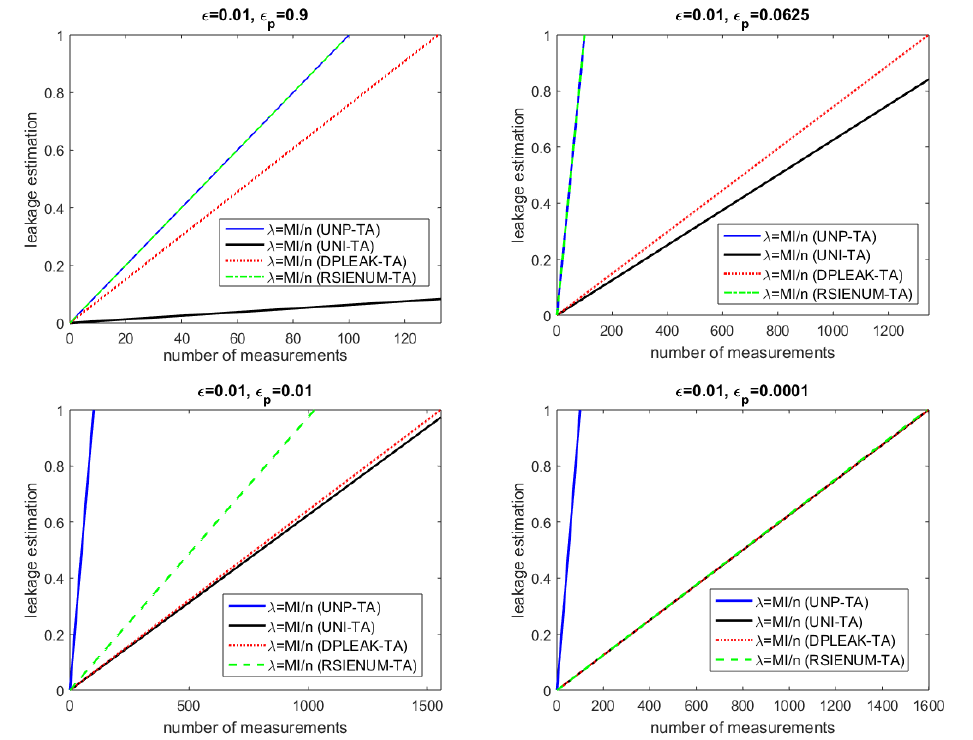
Figure 17: Leakage bounds for shuffled